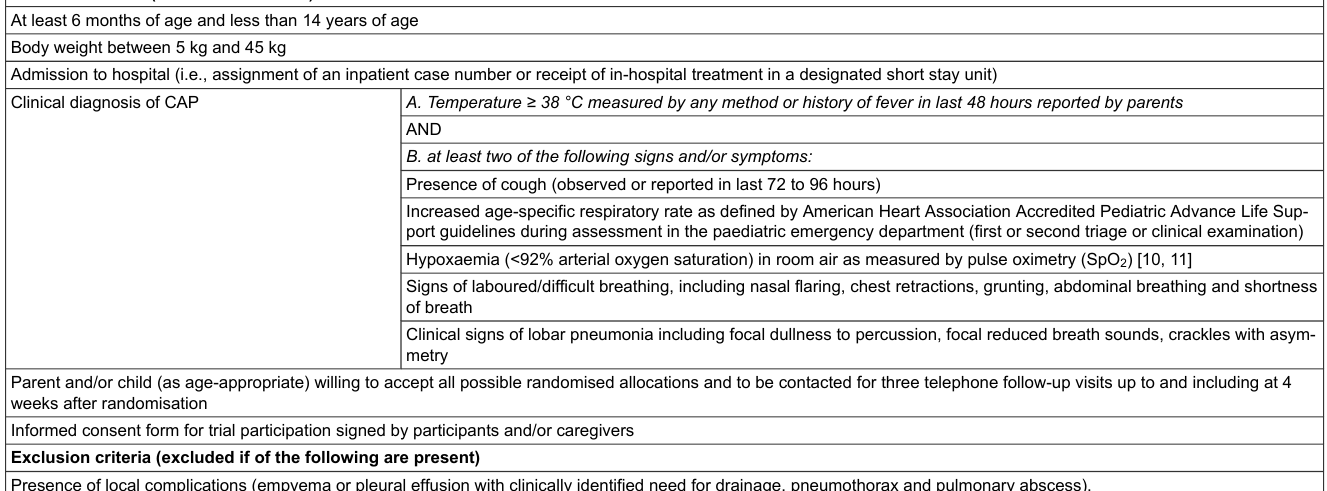
Table 1: Eligibility criteria for the KIDS-STEP trial [8]. Inclusion criteria (all must be fulfilled) Body weight between 5 kg and 45